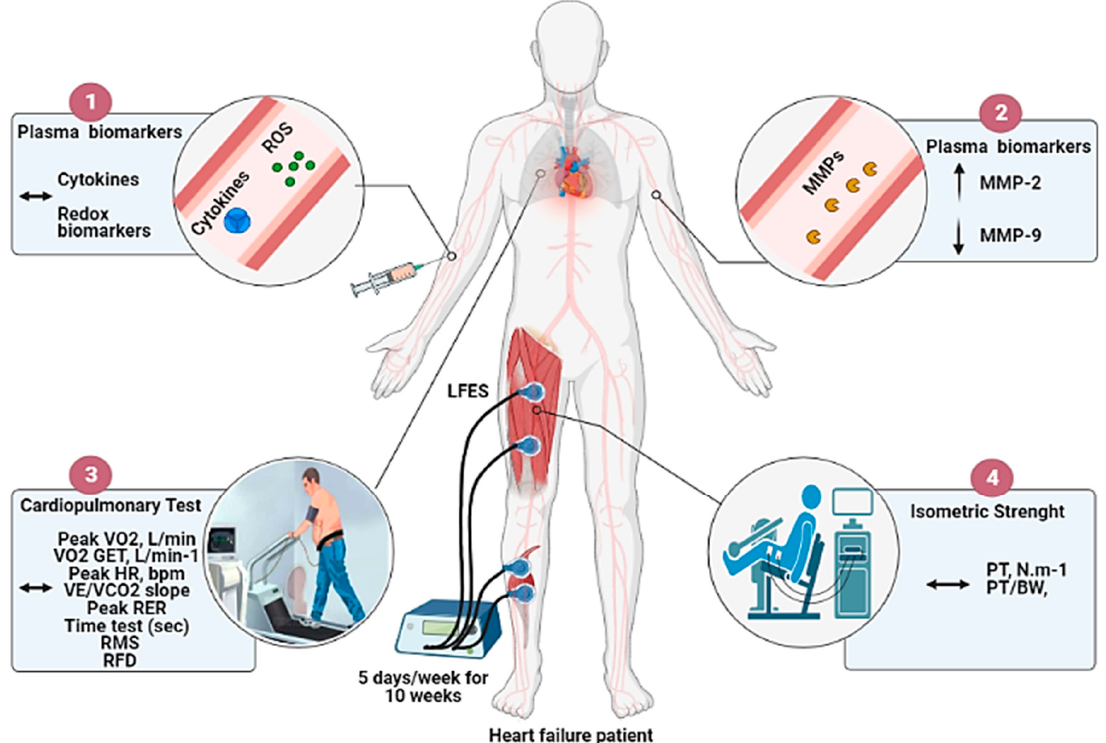
Figure 3. Overview of the effects of LFES on cytokines, redox biomarkers, metalloproteinases activity, cardiorespiratory fitness, and muscle strength in heart failure patients. Note: The 10 weeks of home-based low-frequency electrical stimulation (LFES) protocol: ( 1 ) Does not change plasma cytokines profile and redox biomarkers; ( 2 ) ↑ MMP-2 and ↓ MMP-9 activity; ( 3 ) Does not change cardiorespiratory fitness outcomes ( 4 ) Does not change isometric muscle strength.